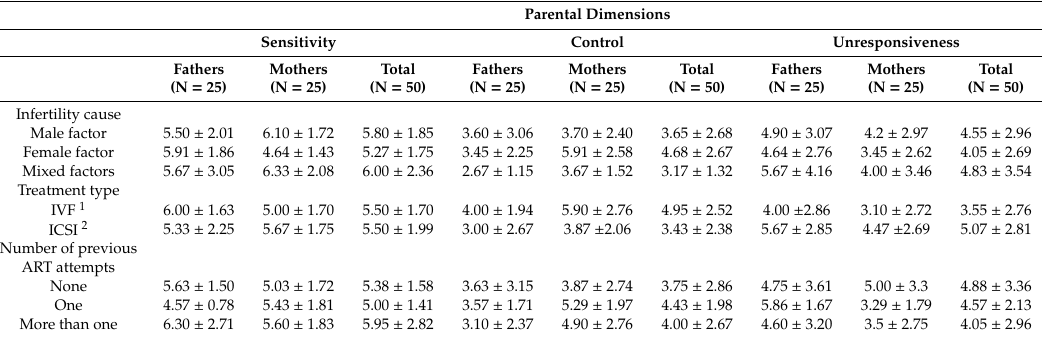
Table 6. Interactive styles (CARE-Index dimensions) in ART parents by infertility cause, treatment type, and number of previous ART